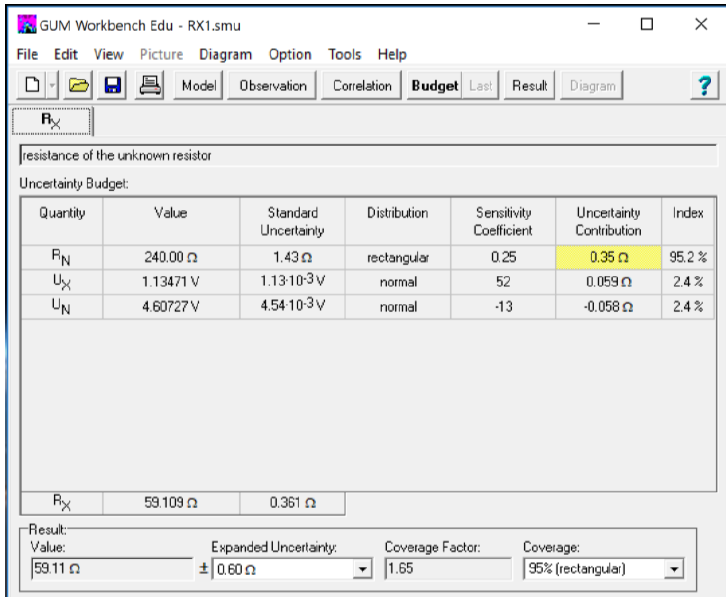
Figure 4. Value of the output quantity R X and its combined uncertainty u C that was obtained by using the GUM Workbench Edu from eleven sets of simultaneous observations.